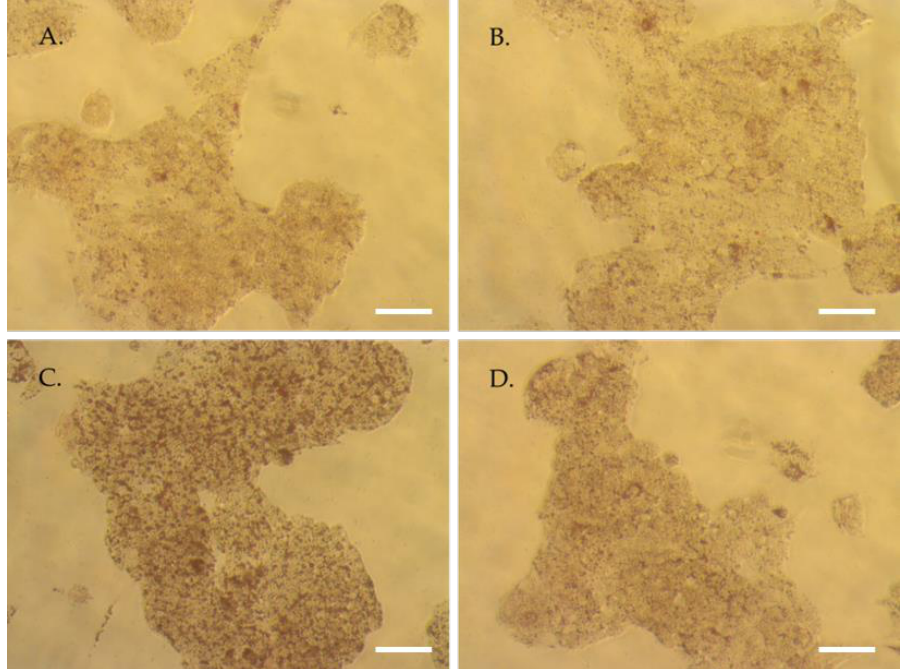
Figure 4. Human HepG2 hepatocytes Red Oil Staining. ( A ) Naïve human serum. ( B ) Human enriched serum with TOTUM-070 metabolites. ( C ) Naïve human serum + palmitate 250 µM. ( D ) Human enriched serum with TOTUM-070 metabolites + palmitate 250 µM. Scale bar, 100 µm.